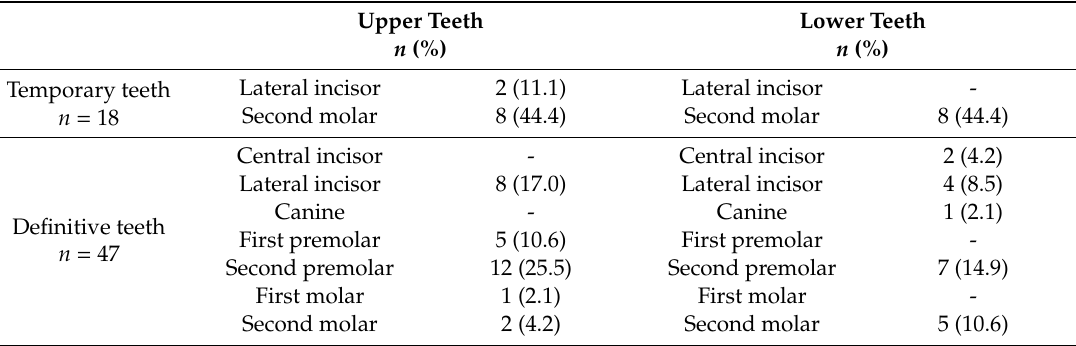
Table 4. Dental agenesis in patients with Wolf-Hirschhorn syndrome.